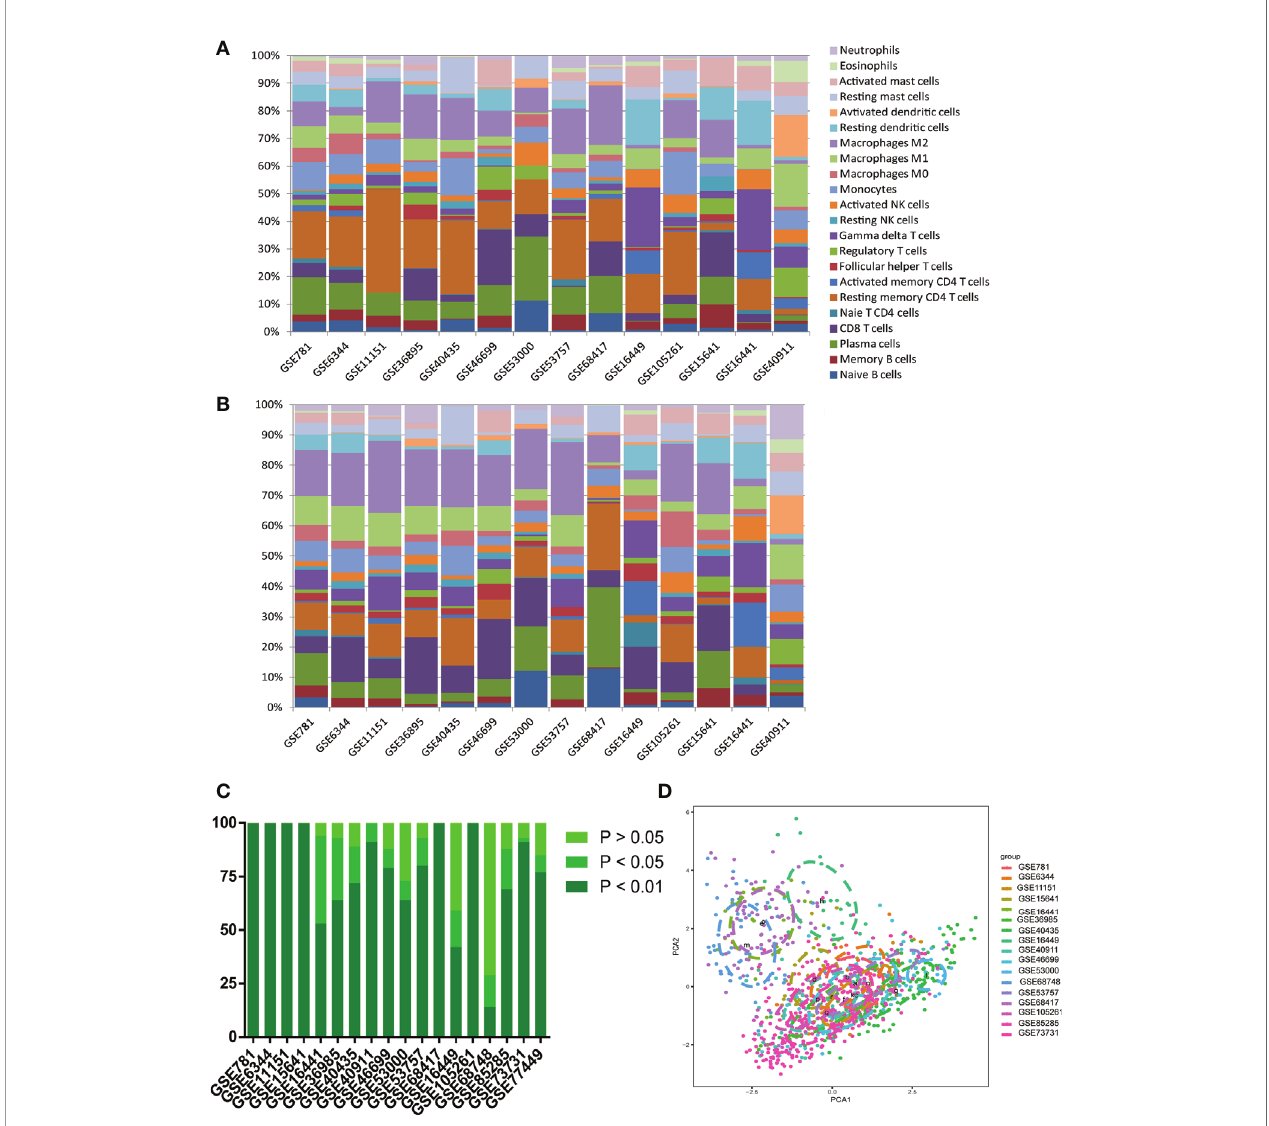
FIGURE 3 | Summary of GEO inferred GEO TIICs composition. (A) Bar charts summarize GEO chips concrete immune cell subset proportions of normal renal tissues. (B) Bar charts summarize GEO chips concrete immune cell subset proportions of RCC tissues. (C) The proportion of chips with different P-value thresholds. (D) PAC depicts the variation of 22 TIICs subpopulations cross all sample from GEO